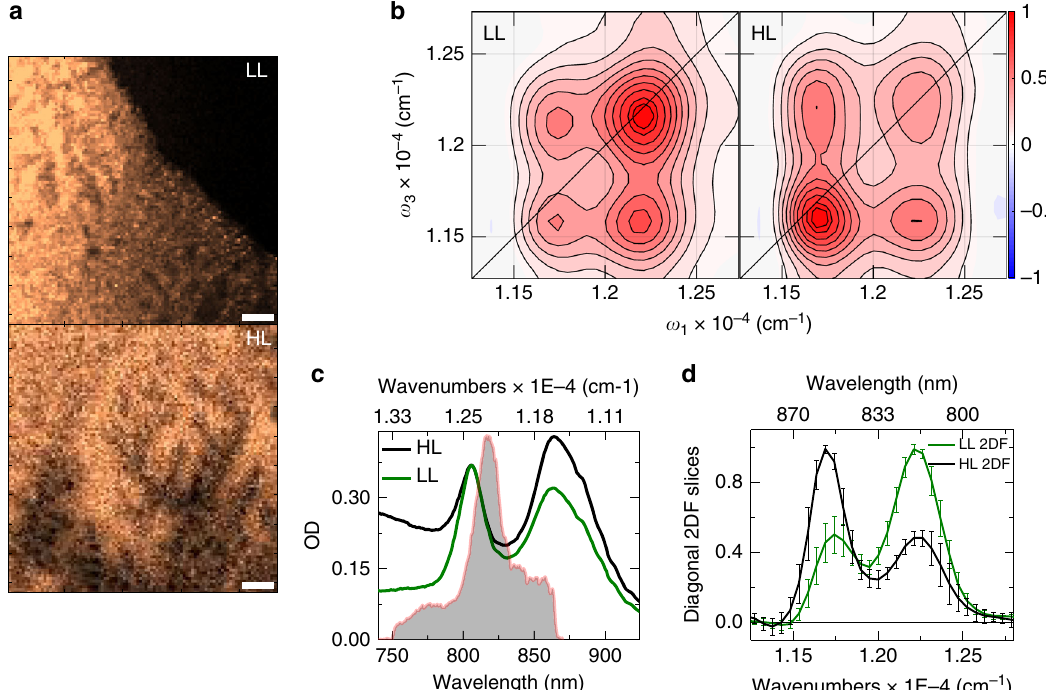
Fig. 2 SF-2DESon unmixed cells of Rps. palustris grown under high and low light (HL and LL). a Confocal fl uorescence images of a drop-dried fi lm of photosynthetic bacteria Rps. palustris . The bacteria were grown under LL (top panel), and HL (bottom panel) conditions. A 10 μ m scale bar is shown for reference. The OD of the live cell solution from which the samples were prepared is shown in panel ( c ) and the drop volume was measured to be ~0.08 μ L through gravimetric analysis (Supplementary Note 3, Supplementary Figure 7). b Absorptive 2D spectra at t 2 = 0 fs obtained by averaging 2D spectra from 5 different XY locations on the LL and HL fl uorescence images, as shown in the left and right panels, respectively. The spectra show distinct cross-peaks at t = 0 fs. The LL and HL 2D spectra are normalized relative to the B800 and B850 bands, respectively, to more clearly emphasize their spectral differences. 2 Contours are drawn at 10 – 90% in steps of 10%, with additional contours at 95 and 100% to highlight small differences in maxima. The frequency ω corresponding to the axes labels on the 2D plots corresponds to ω = | ω ′ |/2 π c , where ω ′ is in rad/fs. c Linear absorption spectrum for LL and HL grown Rps. palustris overlaid with the laser spectrum (gray area). The OD for the LL sample is scaled by a factor of 0.37 such both samples have the same OD at the B800 band. Note that the LL and HL cell concentrations are different. d Slices through the maxima of the upper and lower diagonal peaks of the LL and HL 2D spectra shown in panel b . The error bars are obtained from averaging LL and HL 2D spectra at 5 different locations on the fl uorescence images of panel a . The solid black line across the 2D plot corresponds to the diagonal. All measurements were conducted at 300